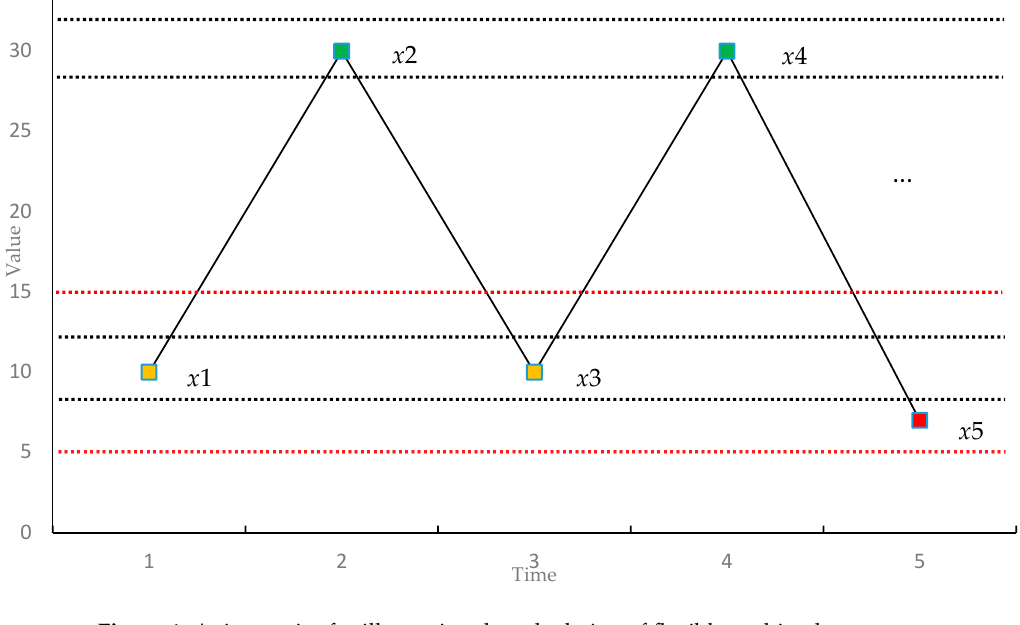
Figure 1. A time series for illustrating the calculation of flexible multiscale entropy.